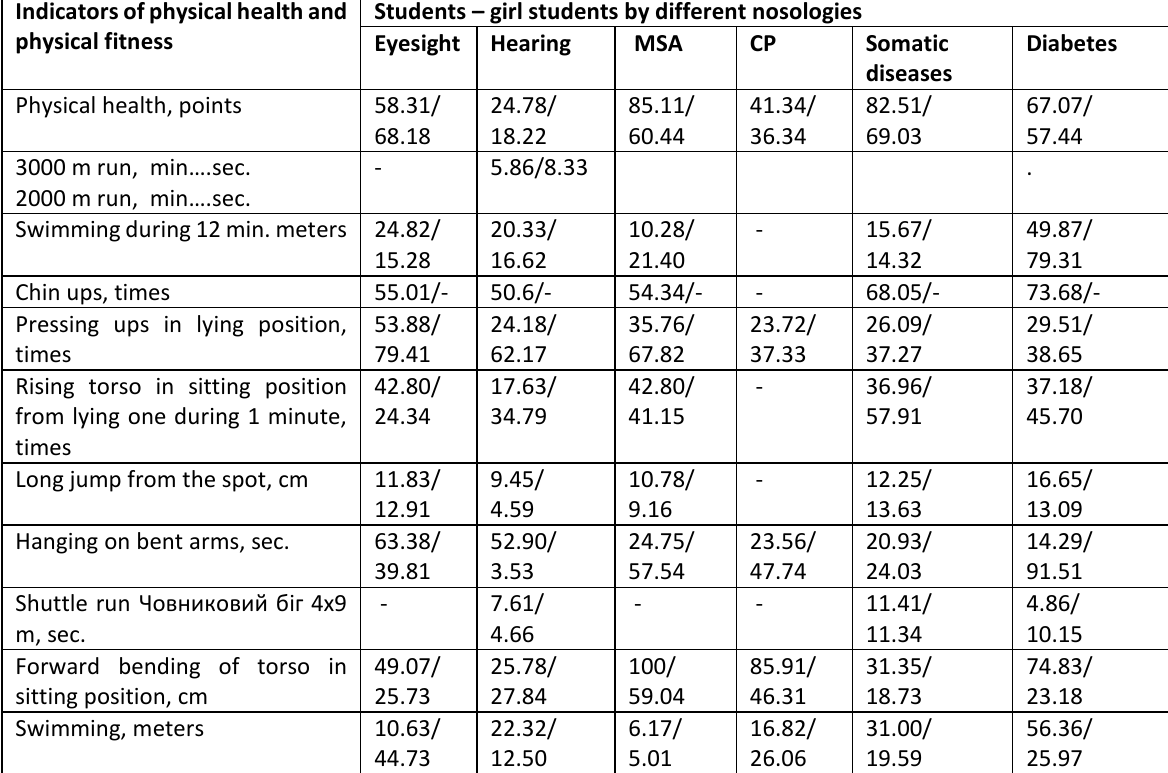
Table 1. Comparative characteristic of influence of new physical education technology on physical health and physical fitness of students after pedagogic experiment (% from initial